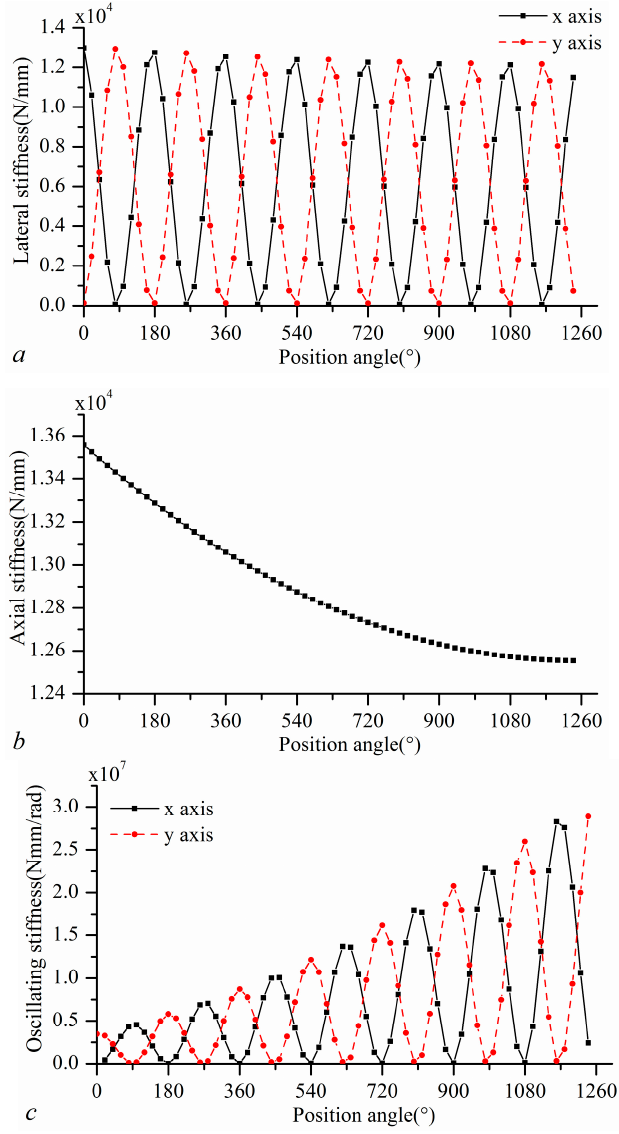
Figure 18. Local stiffness of contact pairs in static state. ( a ) Local lateral stiffness of the x and y axis. ( b ) Local axial stiffness of the z axis. ( c ) Local oscillating stiffness around the x axis and y axis.